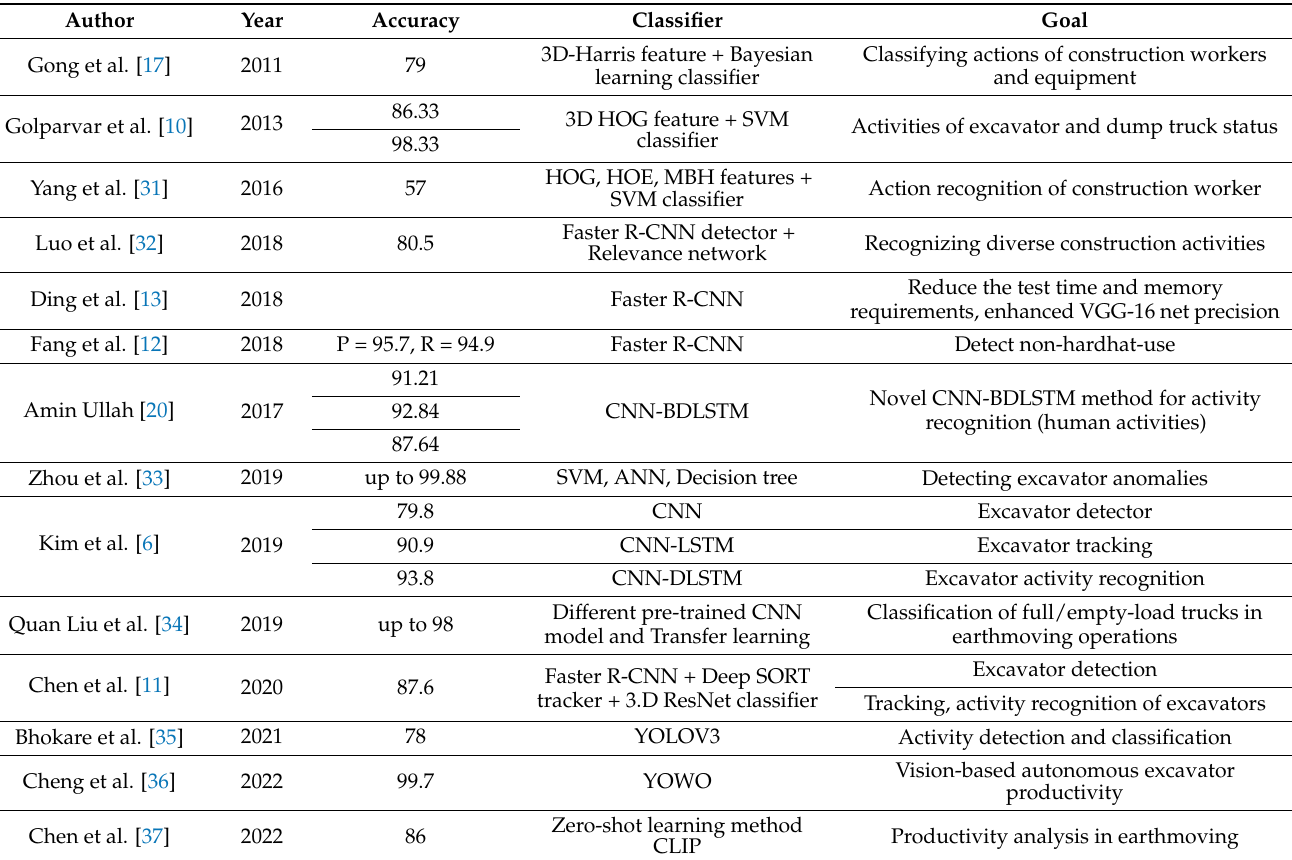
Table 1. Summary of techniques used in the excavator detection and activity